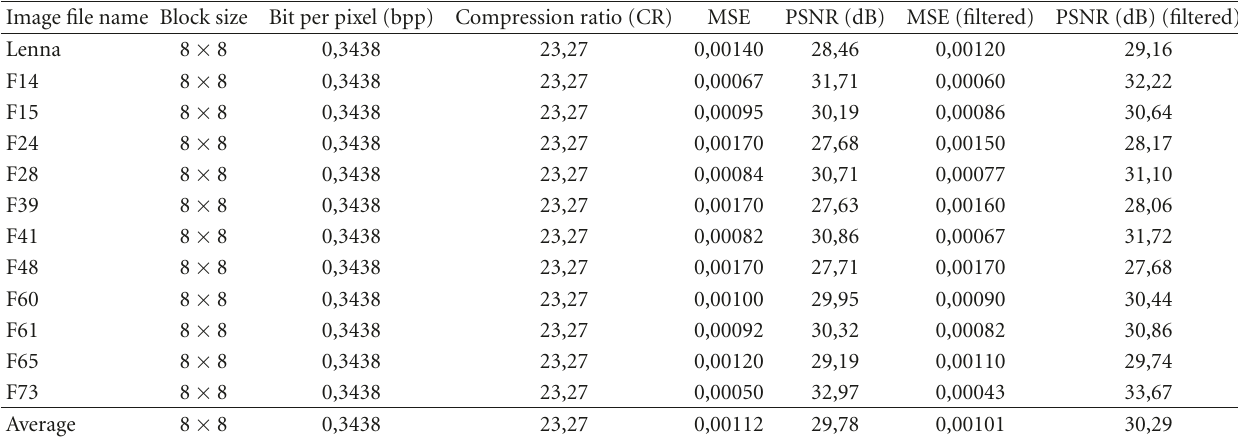
Table 6: Evaluation results of Fold 1 (with clustering).